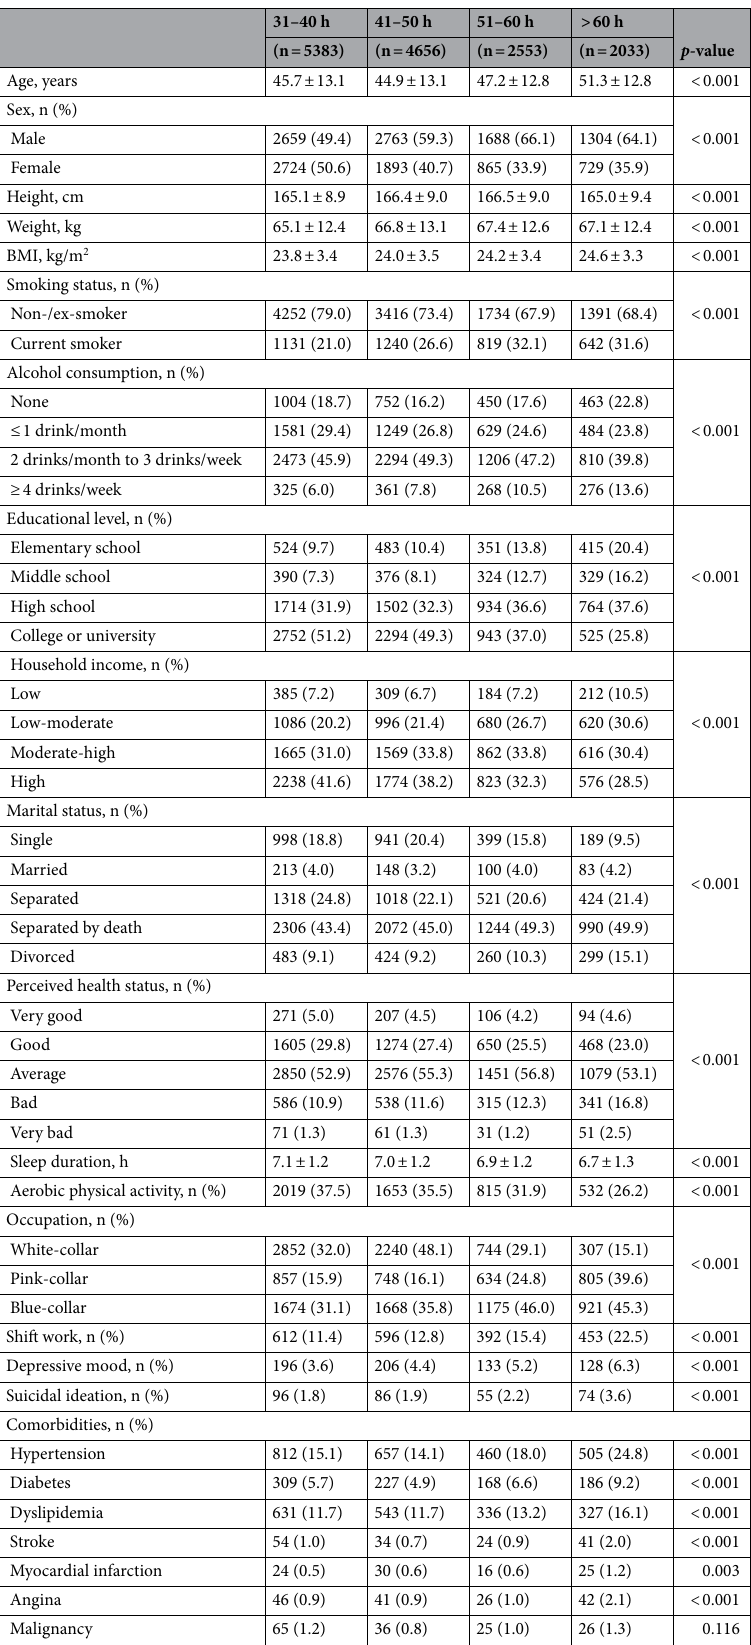
Table 1. General characteristics of the study population. Numerical parameters are expressed as means ± standard deviations and categorical parameters as counts (percentages). BMI body mass